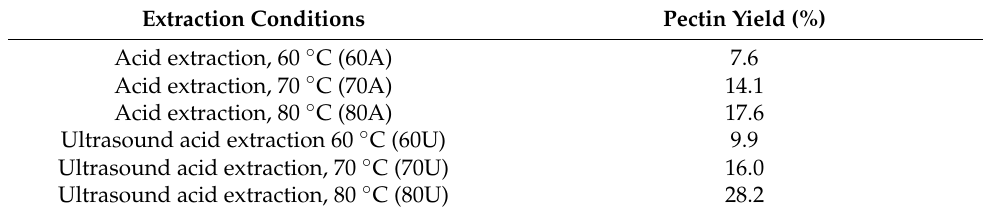
Table 2. Yields of pectins obtained using different extraction conditions.